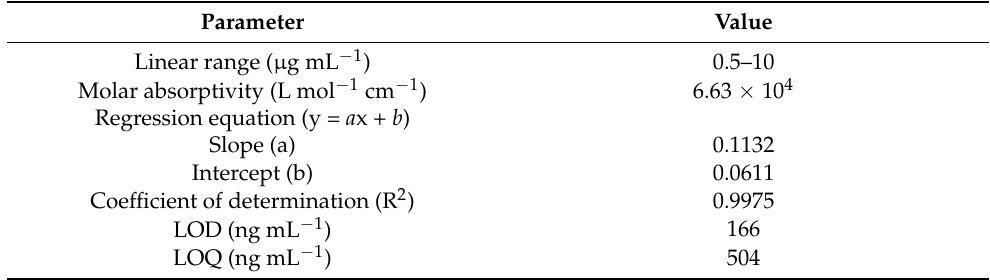
Table 5. Analytical parameters for the determination of TIGC-TCNQ CTC at λ max = 843